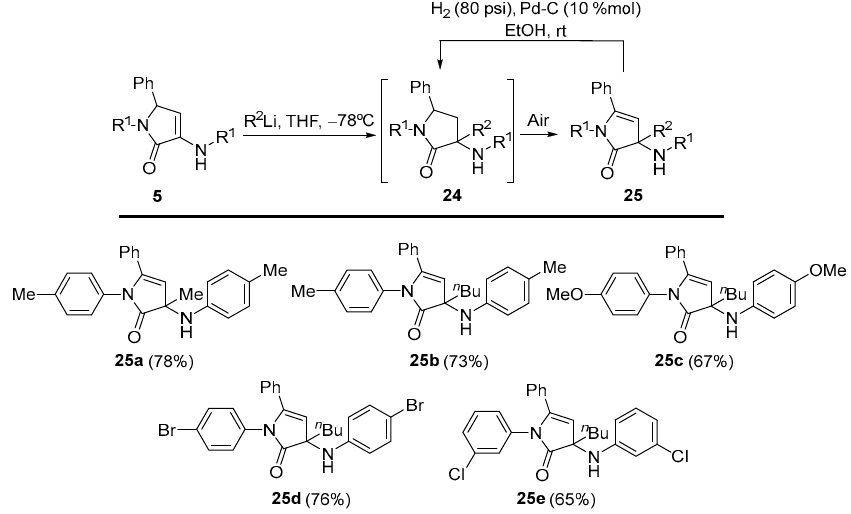
Figure 4. Proposed model for the double nucleophilic addition of cyclic enamine 5b to β , γ -unsaturated α -ketoester 22 (S enantiomer